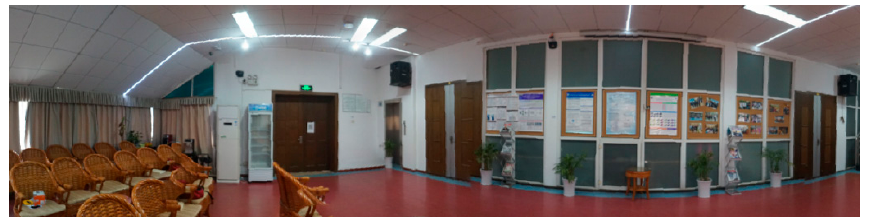
Figure 8. The decorated experimental rooms in a building: (a) location of rooms, (b) undecorated room, and (c) decorated room.